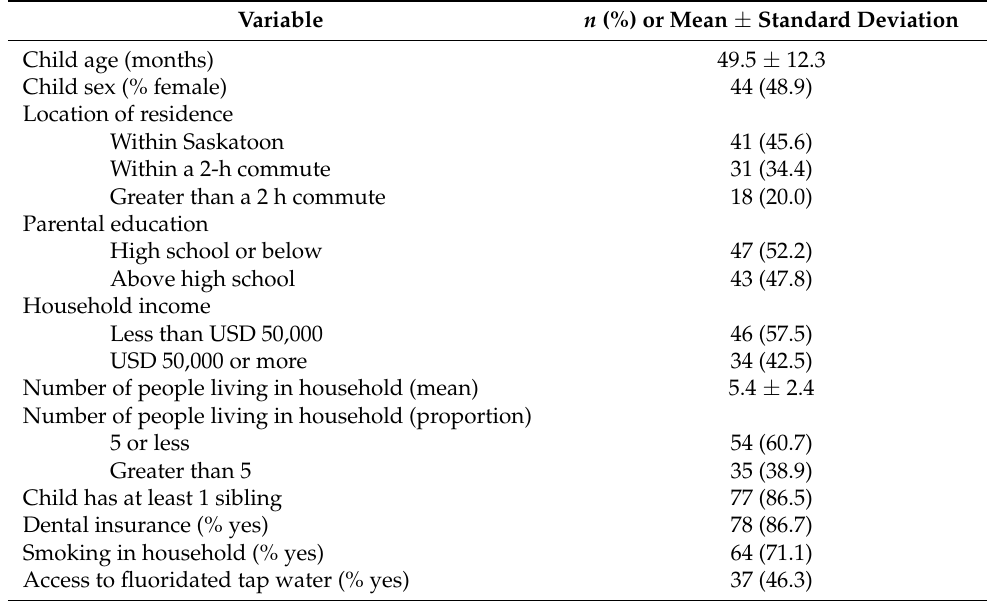
Table 1. Sample population demographics ( n =